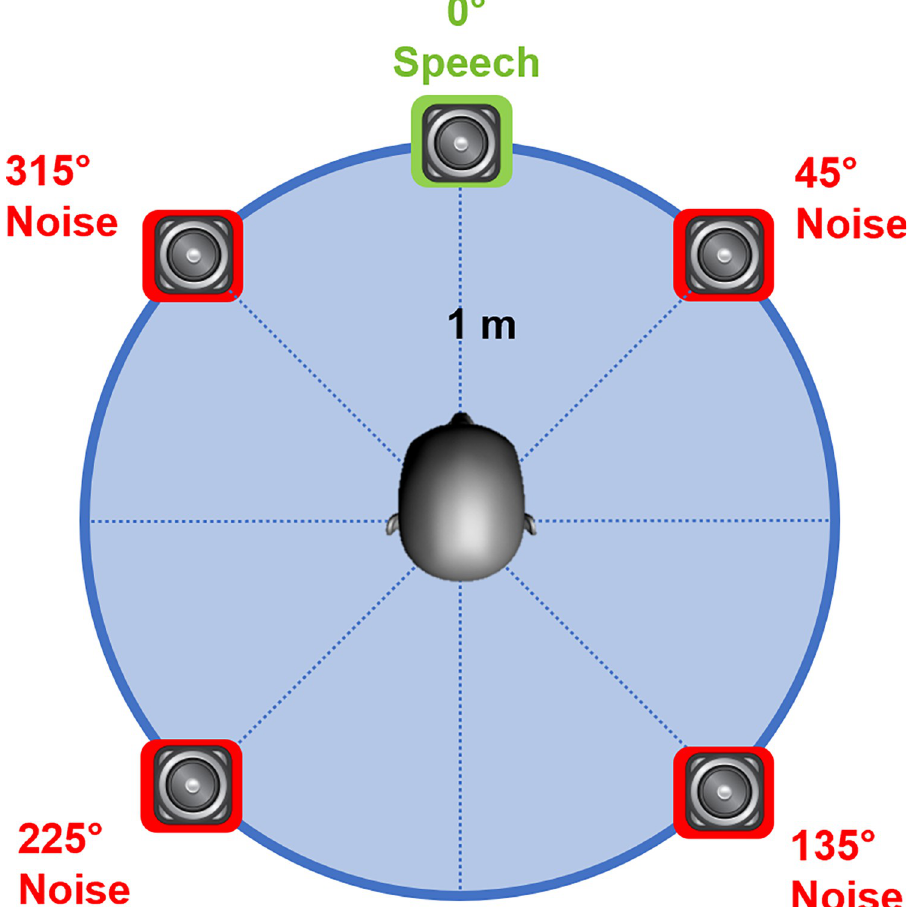
Fig 1. Illustration of the test setup to measure speech understanding in diffuse noise. Speech came from 0˚ azimuth (green speaker) and noise came from 45˚, 135˚, 225˚, and 315˚ azimuth (red speakers) located 1 m away from the center of the listener’s